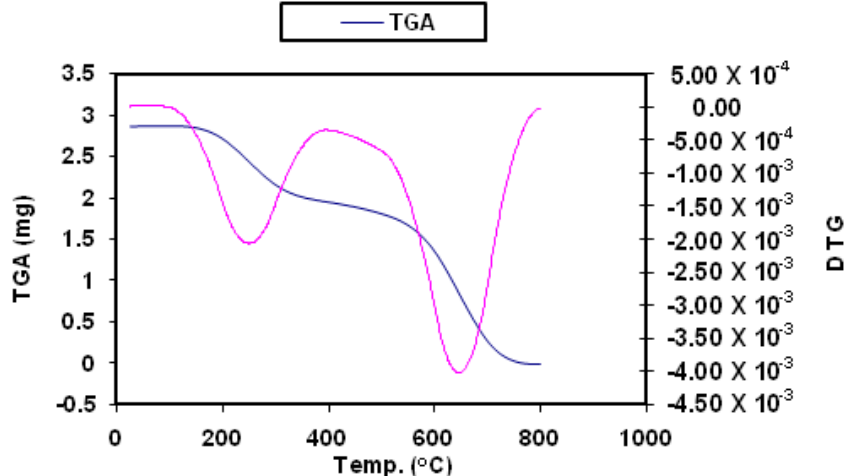
Figure 3. TGA / DTG curves of the [(AMP)(VO)(H 2 O) 2 ] Figure 3. TGA/DTG curves of the [(AMP)(VO)(H 2 O) 2 ] complex.